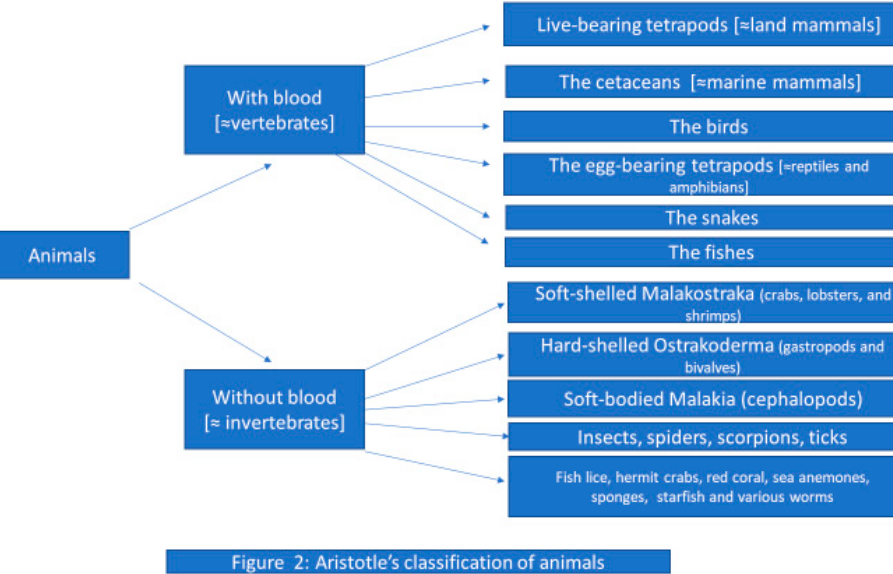
Figure 2. An example of a classification system.